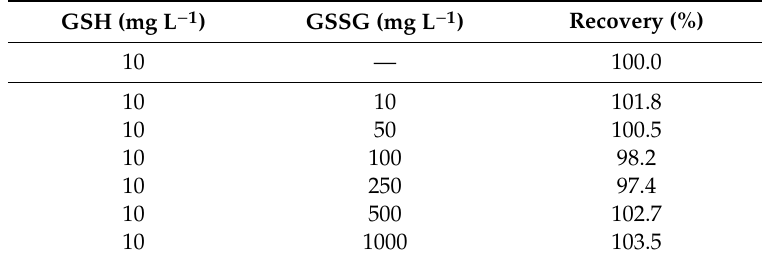
Table 3. Determination of GSH in the presence of GSSG by the OPA flow